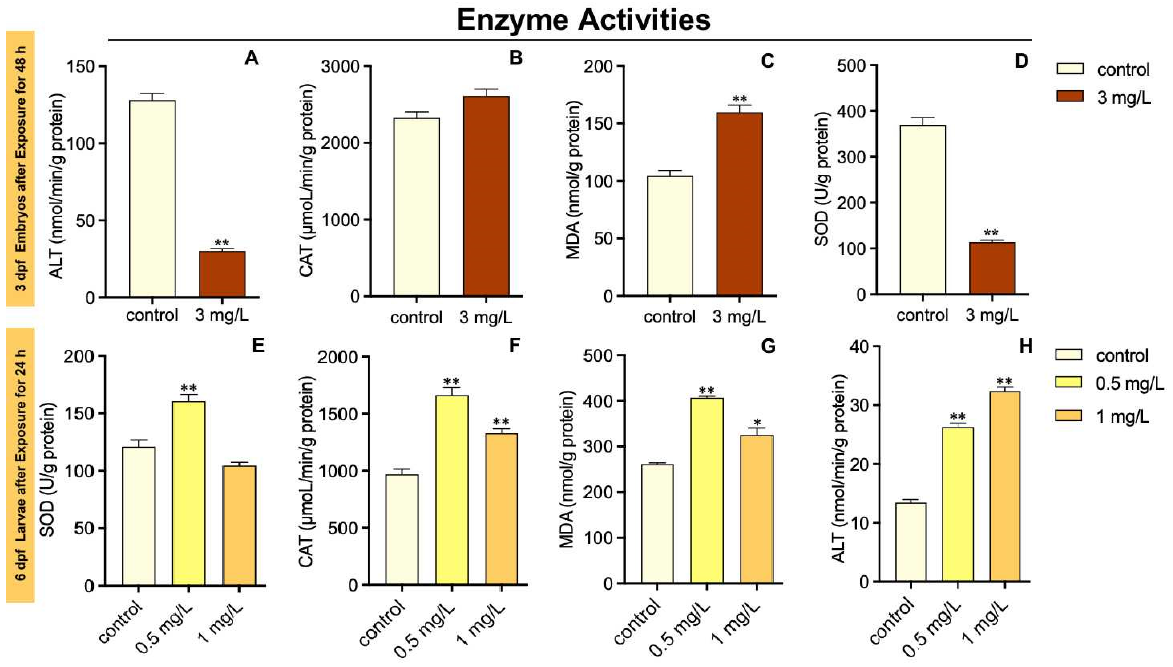
Figure 3. Effects of triflumizole on enzyme activities in zebrafish. For 3 dpf zebrafish embryos, SOD activity ( A ), CAT activity ( B ), MDA content ( C ), and ALT activity ( D ) after triflumizole exposure for 48 h. For 6 dpf zebrafish larvae, SOD activity ( E ), CAT activity ( F ), MDA content ( G ), and ALT activity ( H ) after triflumizole exposure for 24 h. Data are expressed as the mean of three replicates ± standard error (SEM). Asterisks denote significant differences between the control group and TFZ groups (determined by Dunnett post hoc comparison, * p < 0.05, ** p < 0.01). SOD: superoxide